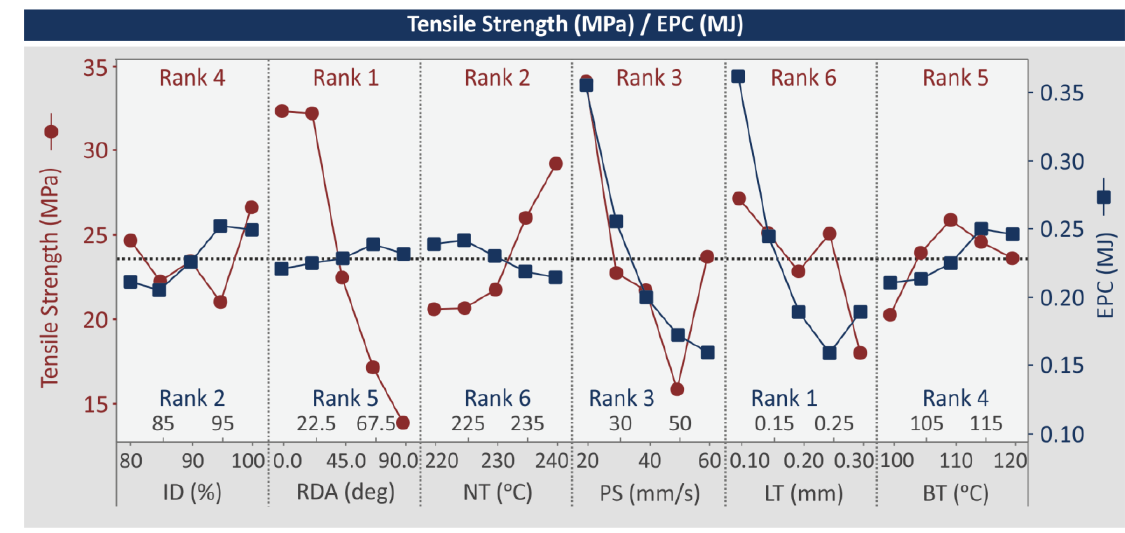
Figure 9. MEP: tensile strength (MPa), EPC (MJ).